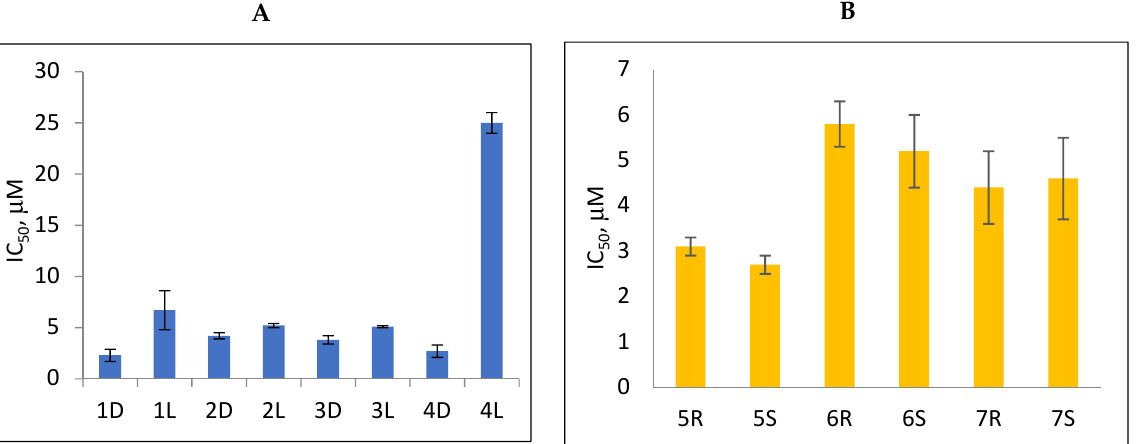
Figure 3. Comparison of Tdp1 inhibition (IC 50 , μ M) by ( A ) D- and L- and ( B ) 5 ′ (R)- and 5 ′ (S)-nucleoside derivatives.